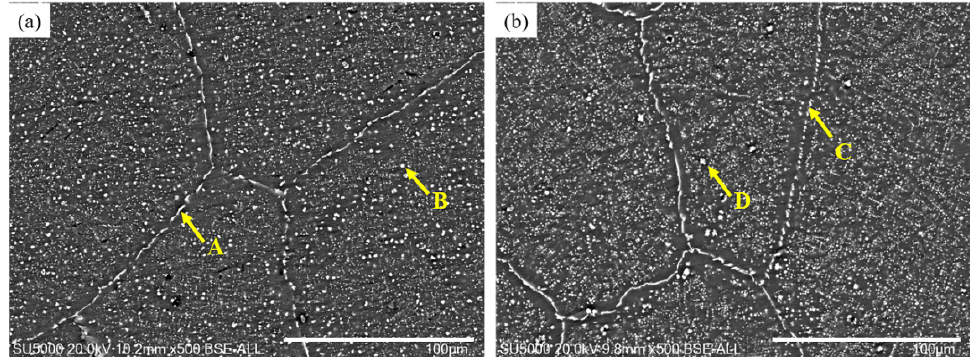
Figure 2. The SEM images of as-cast LAZ13 xy ( x = 3, 6 wt%, y = 3, 6 wt%) alloys: ( a ) LAZ1333, ( b ) LAZ1366. Table 1. The EDS results of the second phases marked by the yellow arrows and letters in Figure 2. Positions